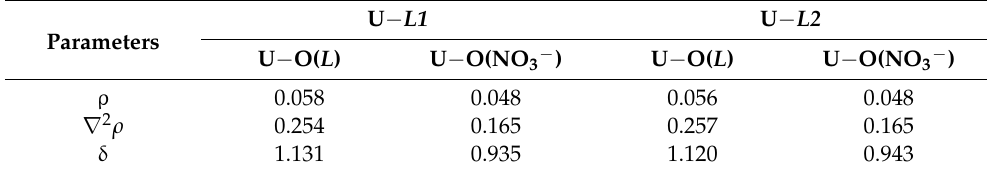
Table 5. QTAIM analyses of ρ (e − /Bohr), ∇ 2 ρ (e − /Bohr), and δ at BCPs of two complexes at the B3LYP/ECP60MWB/6-311g(d,p) level of theory in solution